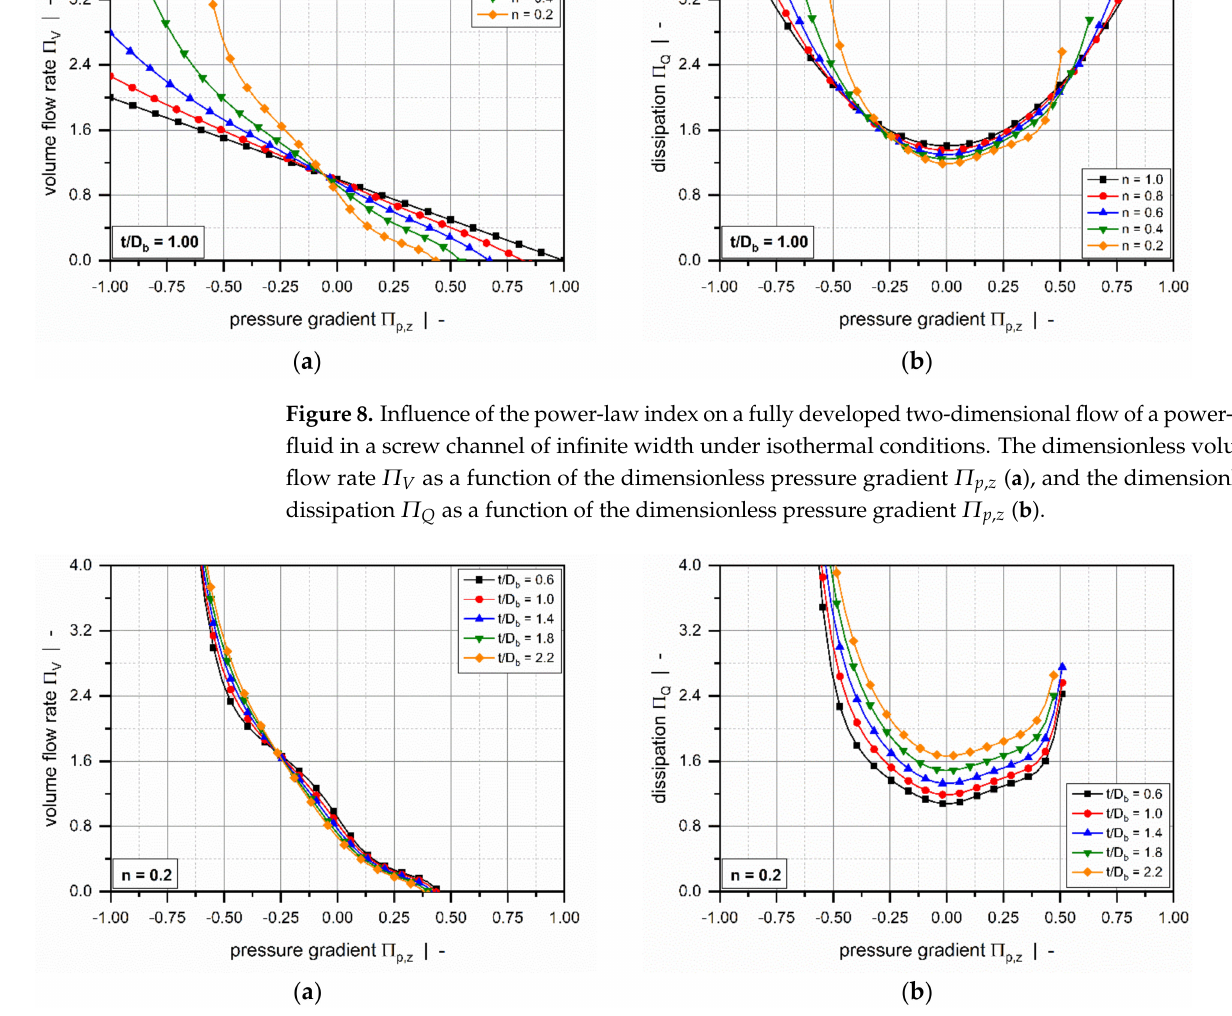
Figure 9. Influence of the power-law index on a fully developed two-dimensional flow of a power-law fluid in a screw channel of infinite width under isothermal conditions. The dimensionless volume flow rate Π V as a function of the dimensionless pressure gradient Π p , z ( a ), and the dimensionless dissipation Π Q as a function of the dimensionless pressure gradient Π p , z ( b